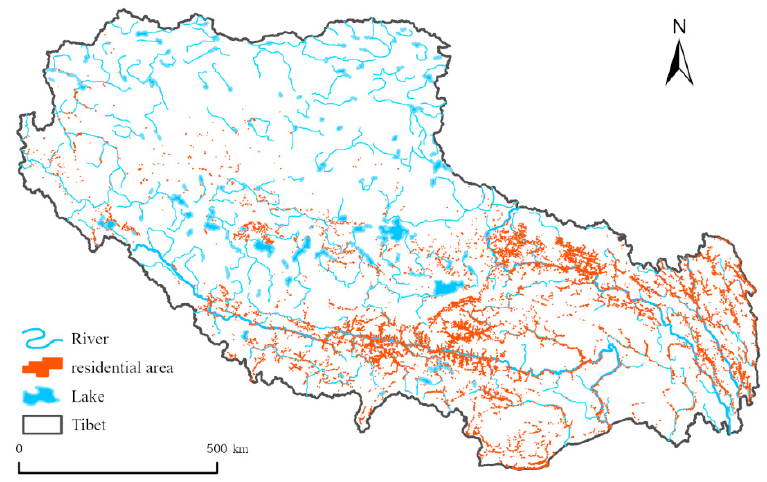
Figure 5. Spatial location map of Tibetan residential areas and waters.